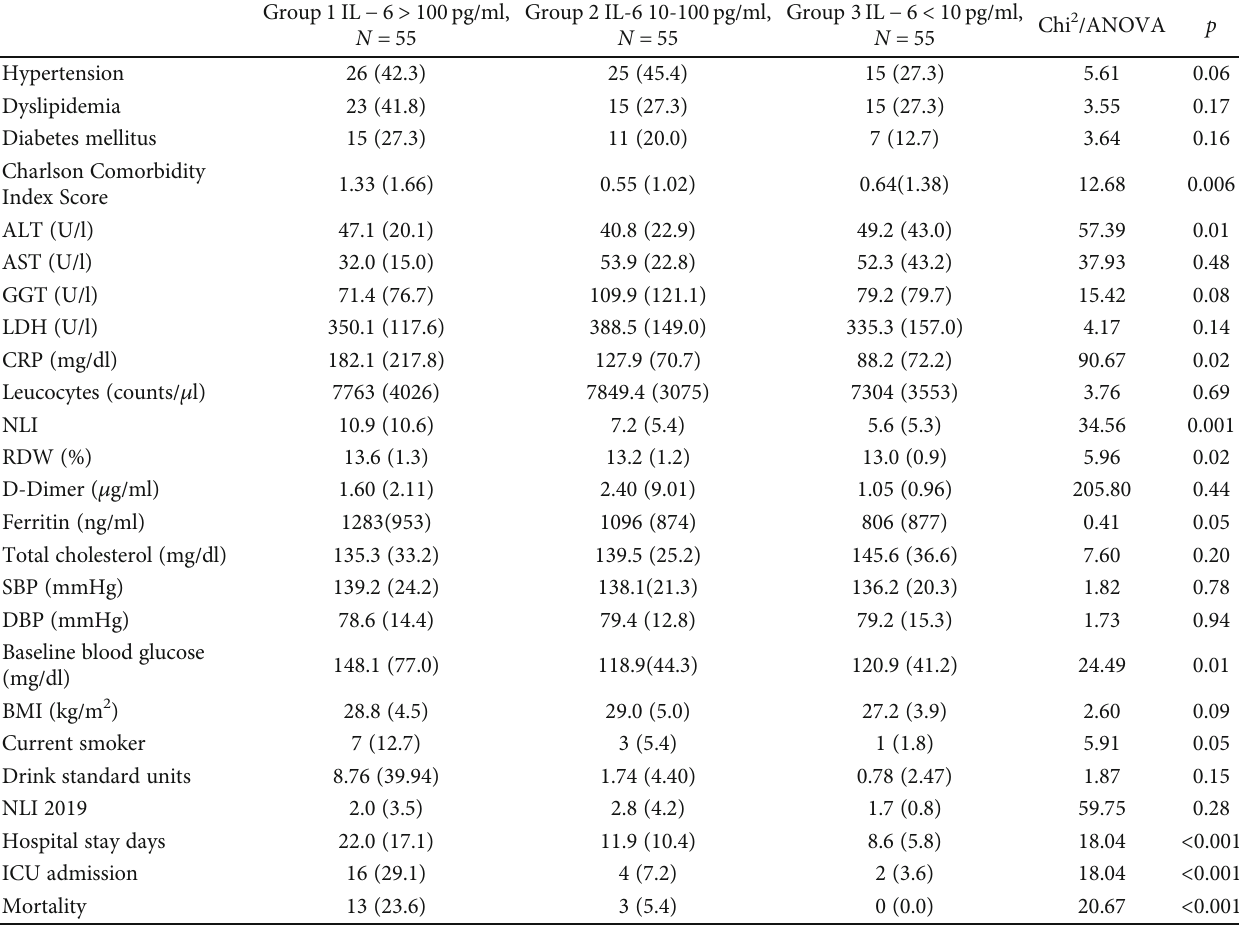
Table 2: Association between IL-6 levels, clinical, anthropometrical, and biochemical determinants.